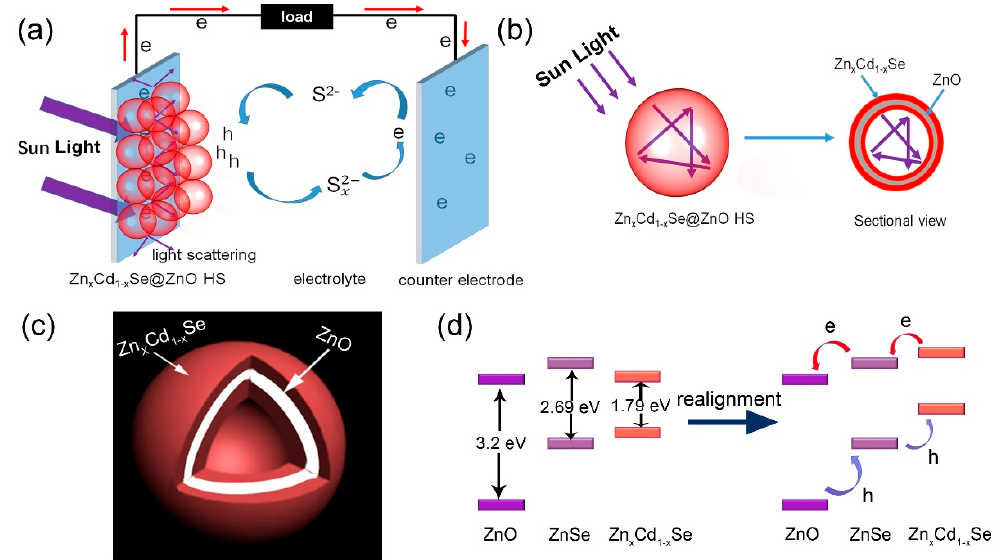
Figure 8. ( a ) The model of the QDSSC based on the Zn x Cd 1-x Se@ZnO photoanode; ( b ) the light pathway inside the Zn x Cd 1-x Se@ZnO HS; ( c ) the composition gradient structural model of Zn x Cd 1-x Se@ZnO HS; ( d ) band edges realignment in Zn x Cd 1-x Se@ZnO